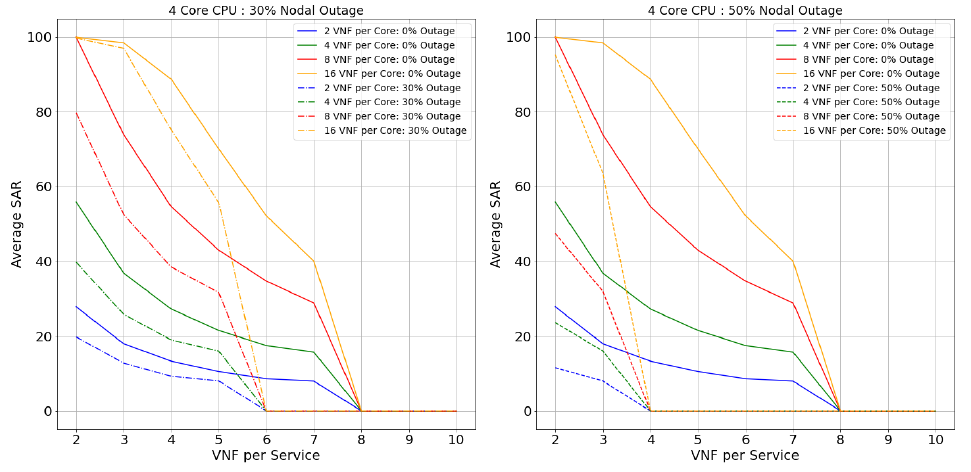
Figure 14. SAR: Netrail Topology with Nodal Outage—4 Core